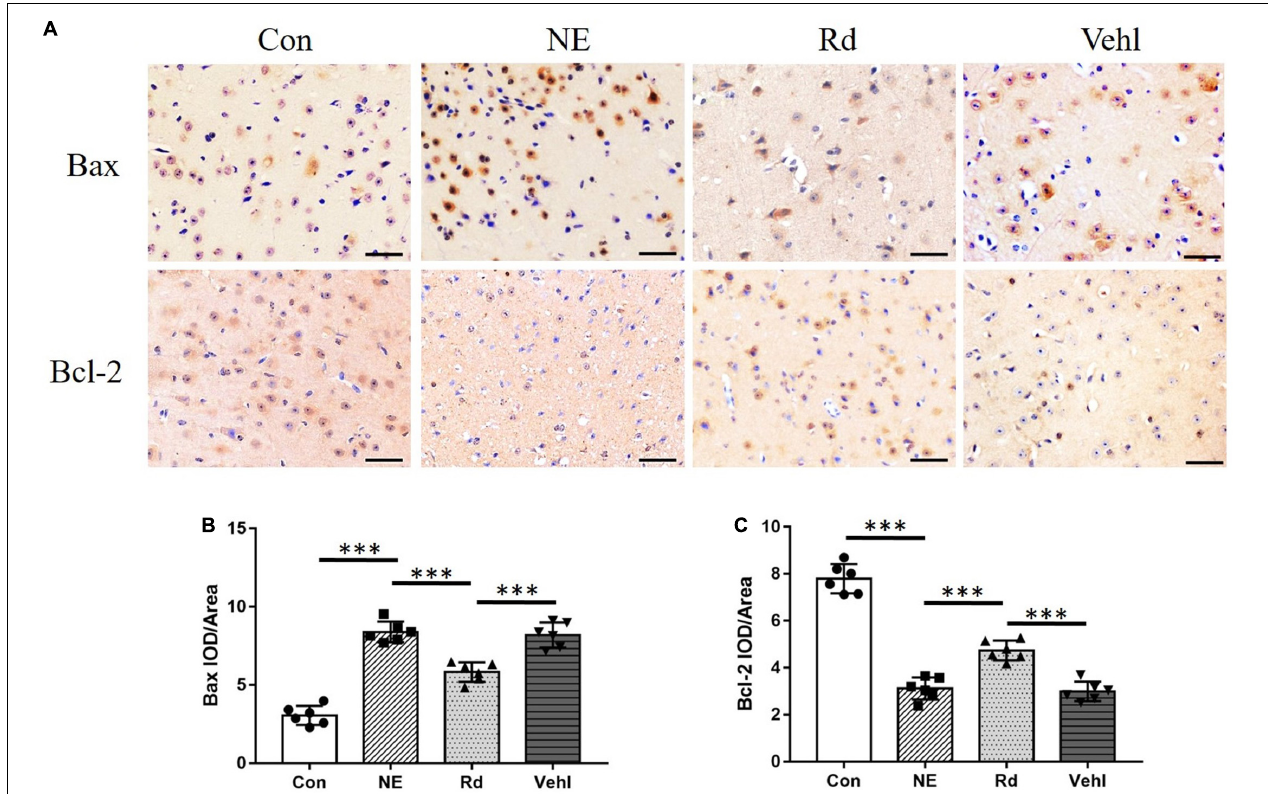
FIGURE 3 | Original images (A) and summarized data (B,C) of immunohistochemical staining (IHC) of Bax and Bcl-2 in the auditory cortices of all groups after exposure to 115 dB (A) noise. Magnification × 400, scale bar = 50 µ m. N = 6 in IHC staining. The values are presented as the means ± SE. *** p <